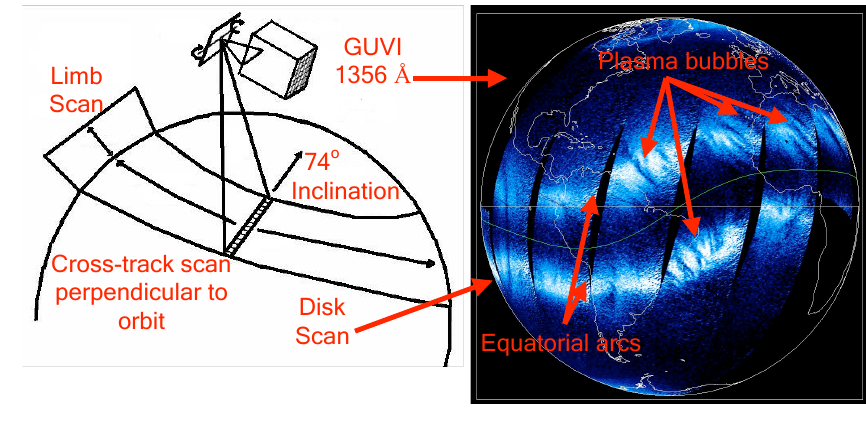
Fig. 1. GUVI scanning geometry (left) and an example of global 135.6nm brightness map indicating plasma depletions (right).